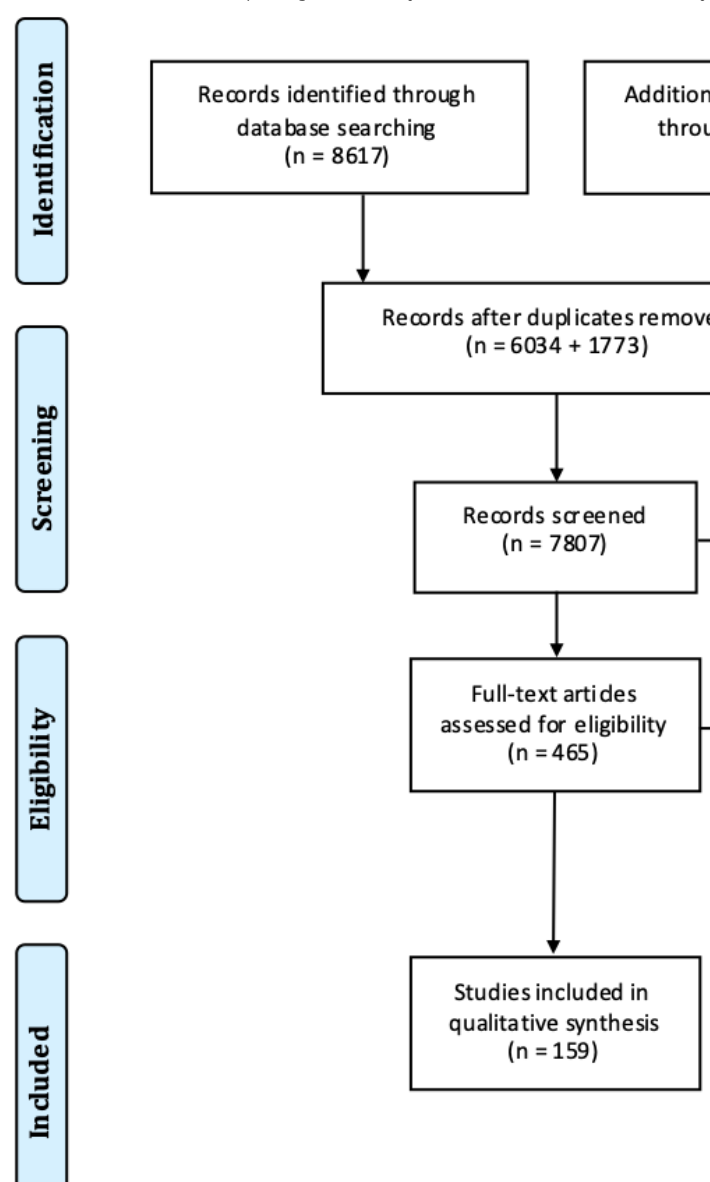
Figure 1. PRISMA (Preferred Reporting Items for Systematic Reviews and Meta-Analyses) flow